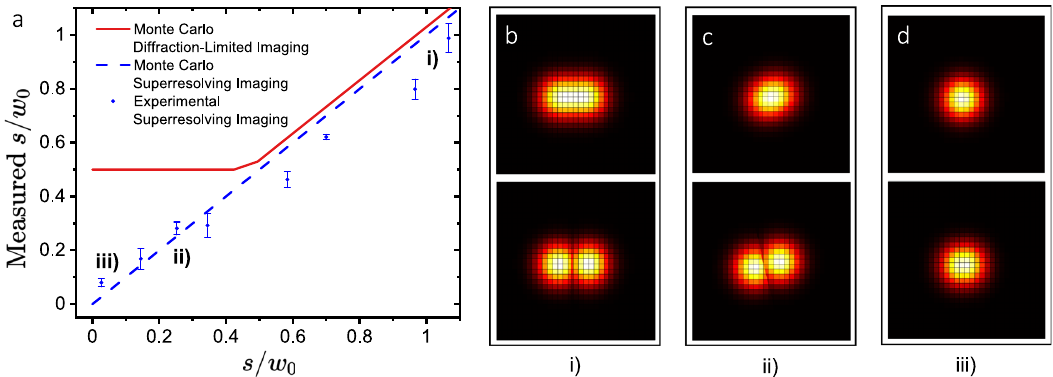
Fig. 5 Comparison between the spatial resolution of our camera and direct imaging. Here the distance is normalized by the beam radius for easy identi fi cation of the Abbe-Rayleigh limit. As shown in a , the red line is the result of a Monte-Carlo simulation for traditional intensity based direct imaging. The plateau is the area where the algorithm becomes unstable. The dotted blue line represents the limit for our supperresolving imaging method, where perfect classi fi cation of each pixel is assumed. The blue dots represent the experimental data collected with our camera for superresolving imaging. The experimental points demonstrate the potential of our technique for identifying spatial features beyond the Abbe-Rayleigh resolution criterion. The fi rst row in the panels from b to d shows the reconstructed spatial pro fi les obtained through direct imaging whereas the second row shows the superresolving images obtained with our technique. The panel in b shows the spatial pro fi les for the experimental point i). This corresponds to the experimental detection of two sources with the largest separation. The spatial pro fi les in c correspond to the experimental point labeled as ii). Finally, the panel in d shows the spatial distributions for the experimental point with the smallest separation, this is labeled as iii ). The error bars are generated by repeating the experiment ten